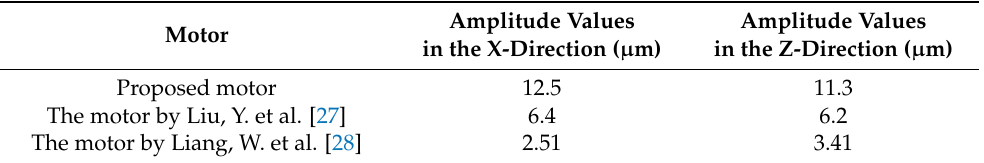
Table 2. Comparison of the amplitude of the three motors. Motor